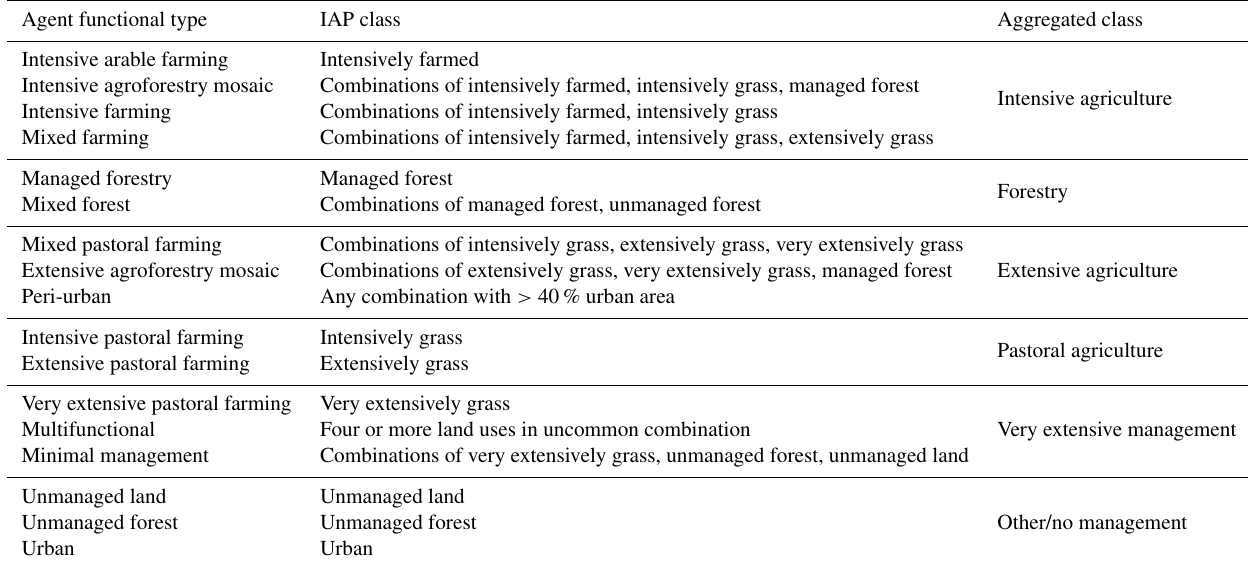
Table A1. The composition of the aggregated land use classes used here in terms of CRAFTY-EU’s agent functional types (AFTs) and the IAP’s land use categories. In any case in which the given IAP categories occupy more than 70% of a cell, that cell is allocated to the corresponding AFT in the baseline map of CRAFTY-EU, except in the case of the peri-urban AFT, for which the threshold (of urban area) is 40%. The service production potentials of each AFT are calibrated to approximately match those within the IAP classes that constitute them so that given the same productivities in a cell, the same levels of services will be produced. Names are therefore assigned in both cases on the basis of dominant land uses and do not account for minor variations in land use and production within